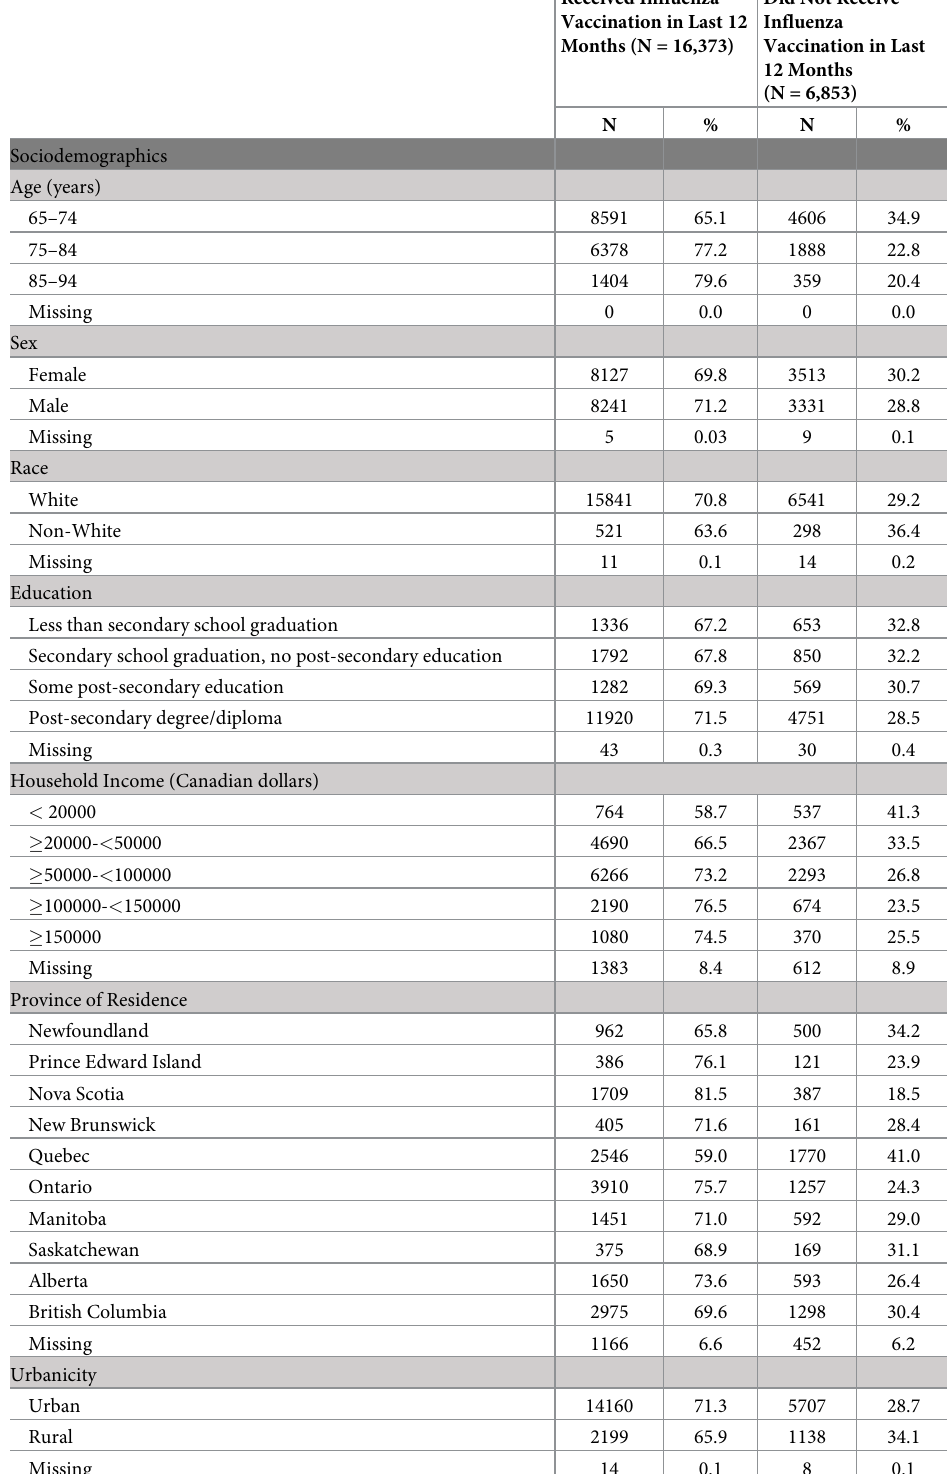
Table 1. Demographic characteristics by influenza vaccination status: Participants aged 65 years and older (N =